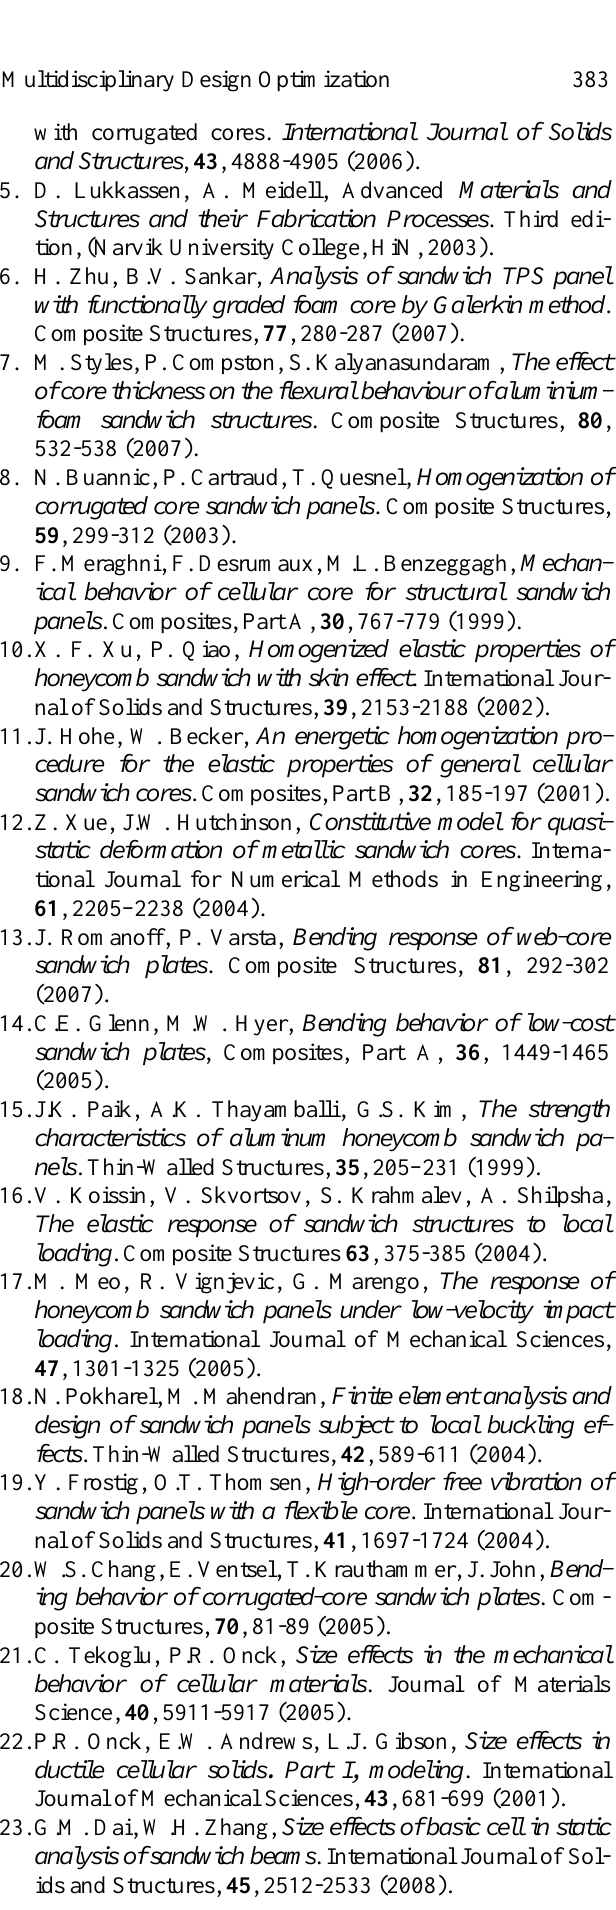
Fig.25. Frequency variation of the fifth order vibration with different size square and rhombic